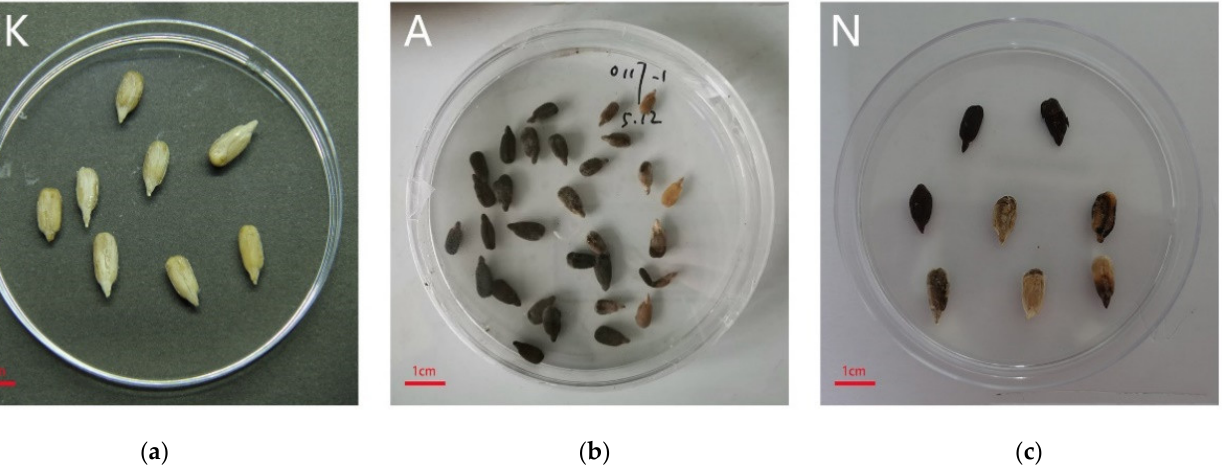
Figure 6. Sunflower seed kernels after reinoculation with mildew-inducing fungi. (CK, sterile water; A, Alternaria spp.; N, post-storage kernels with naturally occurring internal mildew.). ( a ) CK; ( b ) A; ( c ) N.